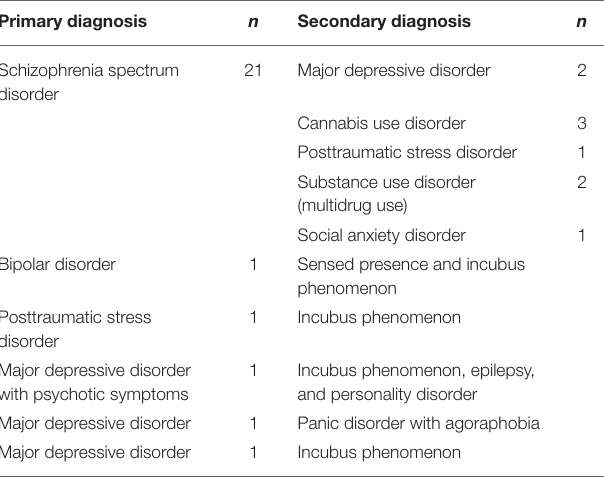
TABLE 2 | Diagnoses of the participants experiencing tactile and/or somatic hallucinations ( N = 26). Primary